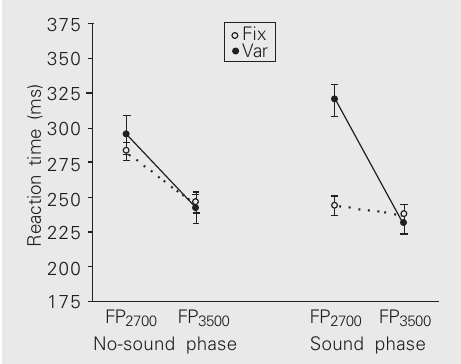
Figure 3. Reaction times of group fix (G Fix ) and group var (G Var ) in the no-sound and sound phases of the second testing session of